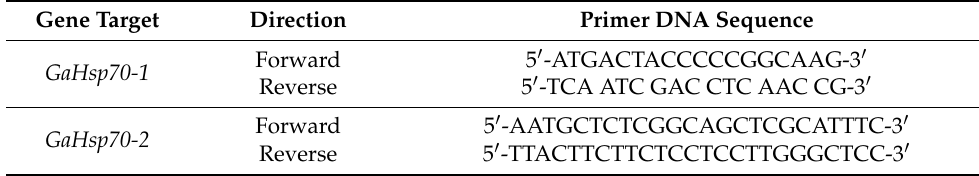
Table 2. Primers used for cDNA